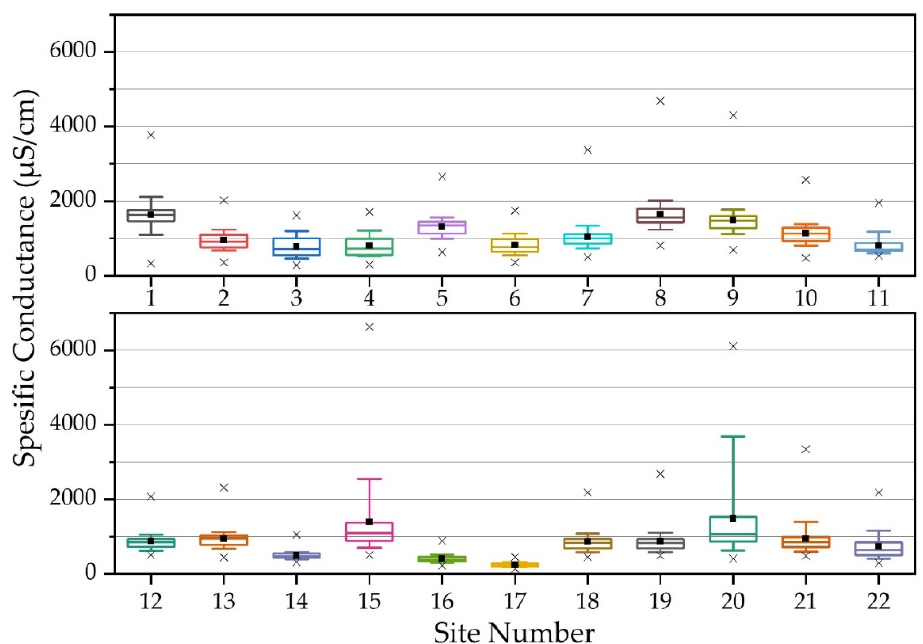
Figure 6. Box and whisker plot of specific conductance (µS/cm) descriptive statistics at 22 sampling locations during study period (2 January 2018–1 January 2019) in West Run Watershed, Morgantown, WV, USA. Box delineates 25th and 75th percentiles; line denotes median; square shows mean; whisker describes 10th and 90th percentiles; x shows maximum and minimum when above and below, respectively. Water 2020 , 12 , x FOR PEER REVIEW